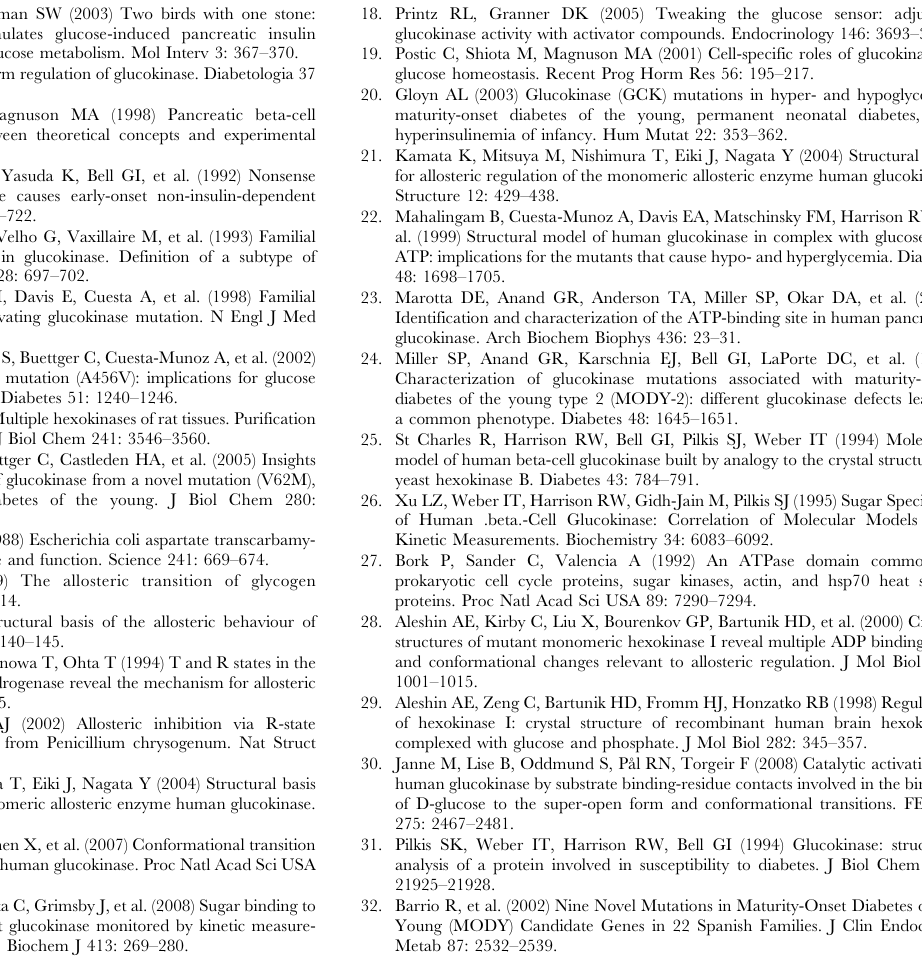
Figure S5 Fluorescence emission spectra of recombinant hLGK2 (wild-type) and K169A mutant proteins. Fluorescence emission spectra of the recombinant proteins were monitored at the concentration of 5 m M/L in 20 mM NaH 2 PO 4 buffer (pH 7.1). Found at: doi:10.1371/journal.pone.0006304.s007 (4.27 MB TIF) Figure S6 The partitioning scheme of QM and MM regions for the GMAG complex in the QM/MM calculations. Atoms in the QM region are displayed in ball and stick. ATP, Mg 2 + , glucose and important residues in GK are labeled. Found at: doi:10.1371/journal.pone.0006304.s008 (4.45 MB TIF) Figure S7 A close view of the configuration of K169N in the environment of GK active site. Found at: doi:10.1371/journal.pone.0006304.s009 (0.62 MB